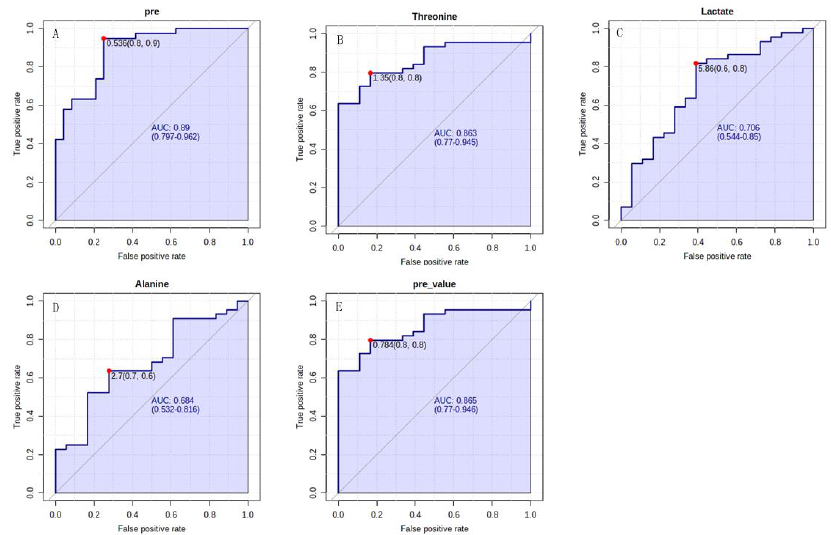
Figure 5. The ROC curve analyses of PAH − CHD vs. CHD. ( A ) The ROC curve generated by predictive values of probability from binary logistic regression model with lactate and threonine for diagnosis of PAH − CHD; ( B – D ) Univariate ROC curves of lactate, threonine and alanine for diagnosis of right heart dysfunction; ( E ) The ROC curve generated by predictive values of probability from binary logistic regression model with lactate, threonine and alanine for diagnosis of right heart dysfunction.